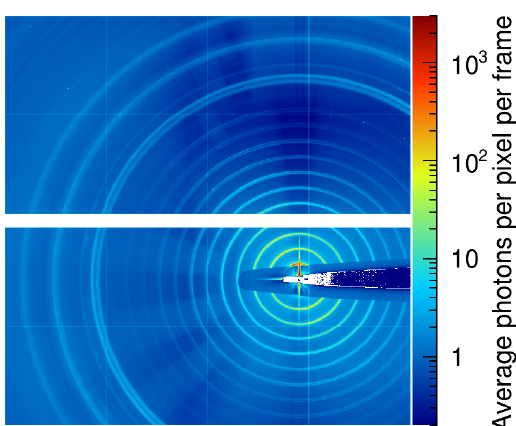
Figure 22. Image recorded with a 1M JUNGFRAU system for a silver behenate powder sample at the LCLS XCS instrument. The image is averaged over 10,000 LCLS